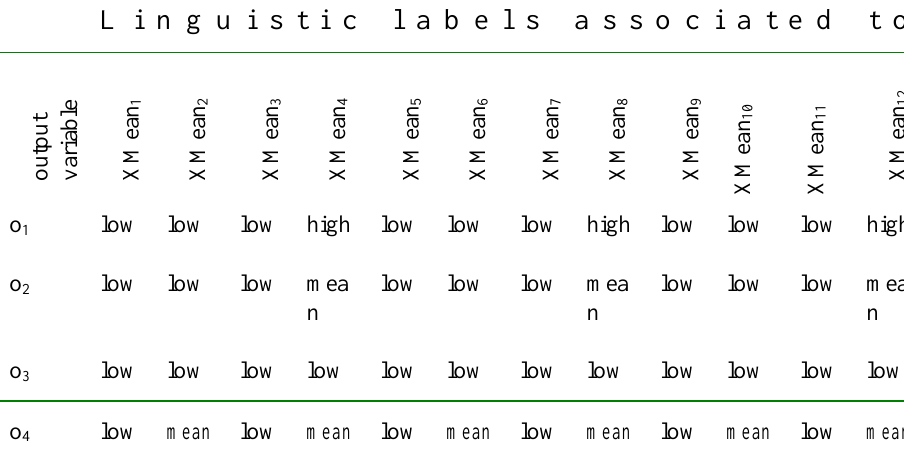
Table 7. Final linguistic labels for the output variables in the district